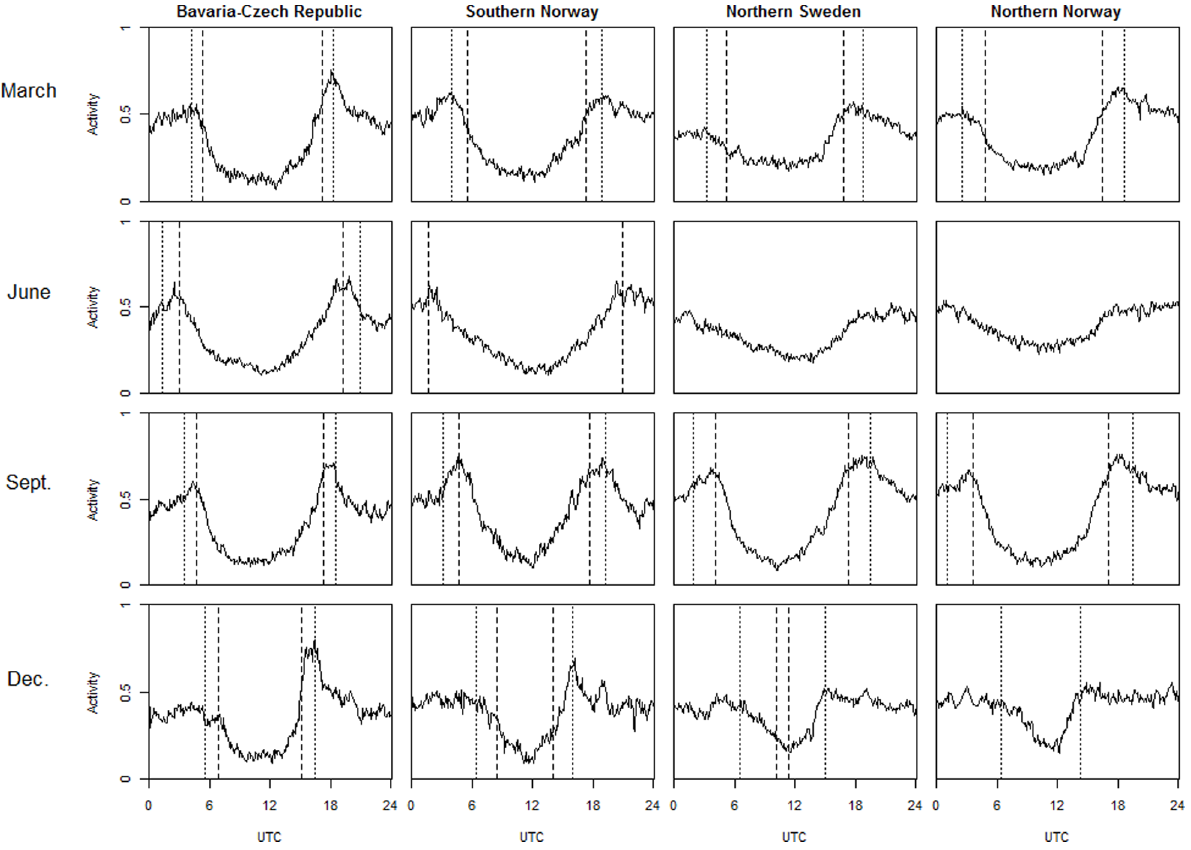
Fig. 3. Eurasian lynx daily activity at the four study sites. Each plot shows the portion of time spent active per hour (activity) over the course of a day in the month and averaged over the number of lynx in the area indicated. Dashed vertical lines, sunset and sunrise; dotted lines, beginning and end of